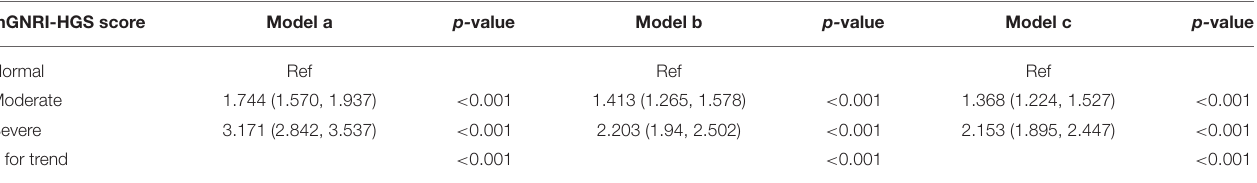
TABLE 1 | Trend test of the relationship between mGNRI-HGS score and survival.